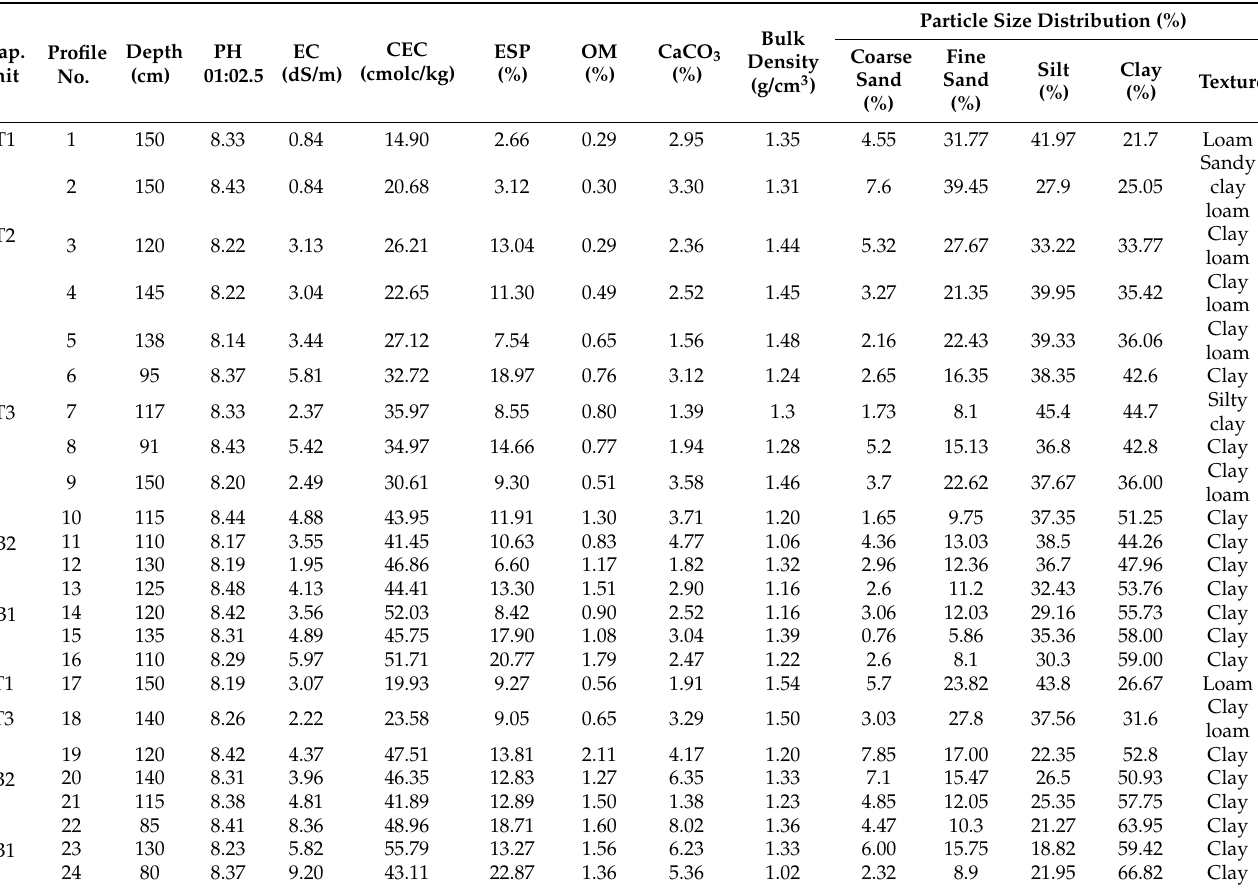
Table 2. The main physical and chemical properties of the studied soil